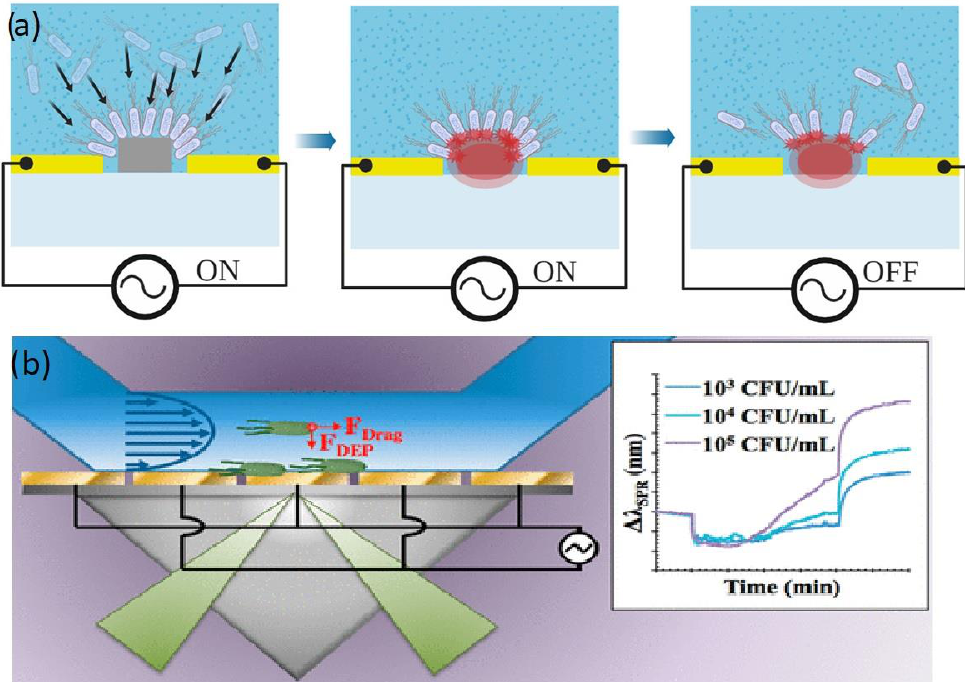
Figure 5. ( a ) Capture of E.coli on a silicon waveguide. Reproduced under terms of the CC-BY license Ref. [78]. ( b ) Schematic figure of a microbial SPR sensor, reproduced with permission [90] 2018, American Chemical Society.